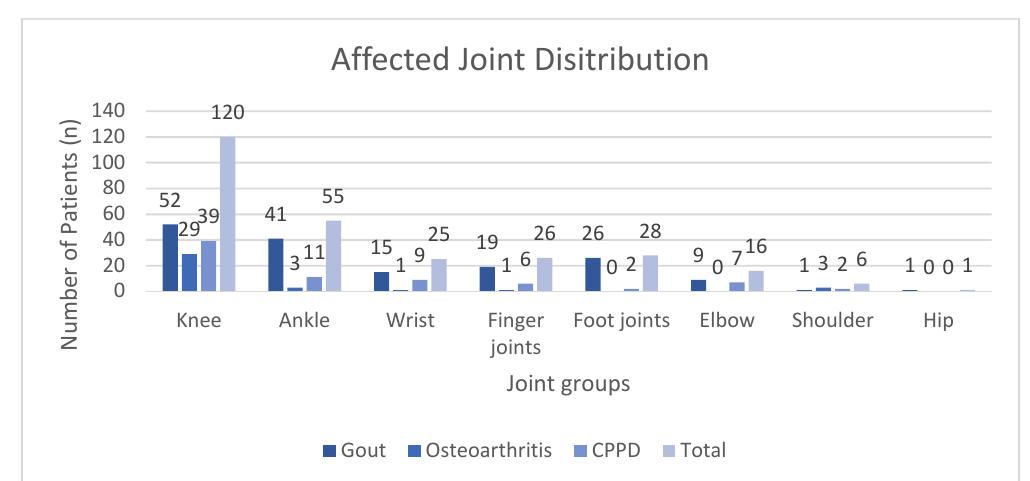
Figure 2. Distribution of the affected joints for each diagnosis grouped by joint categories. CPPD: calcium pyrophosphate deposition disease.